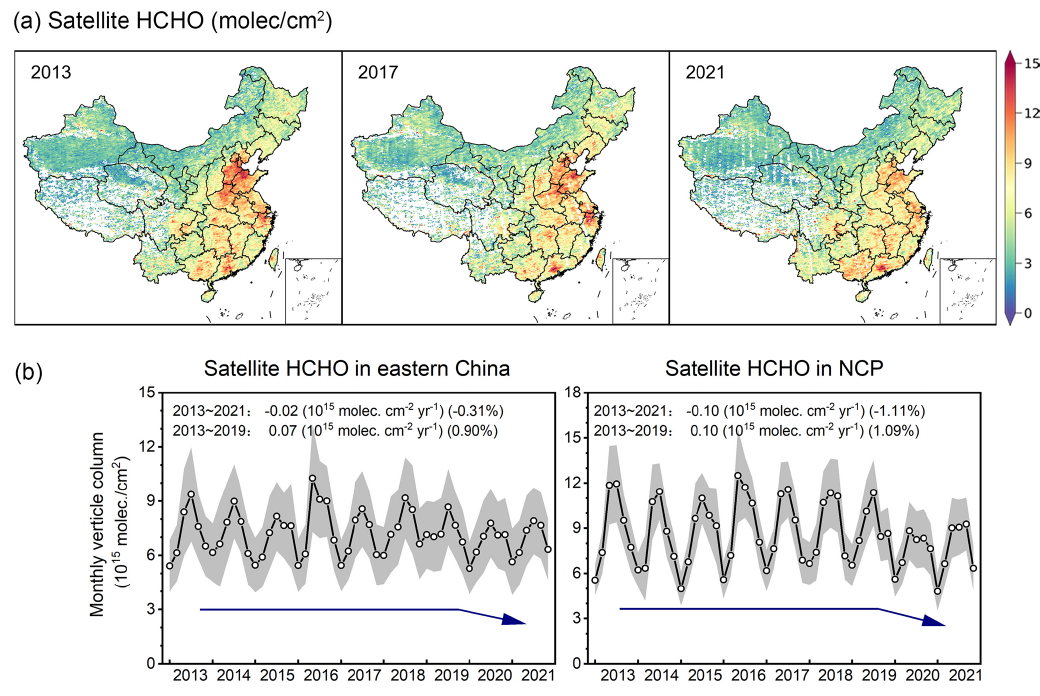
Figure 6. Same as Fig. 5 but for satellite-based HCHO